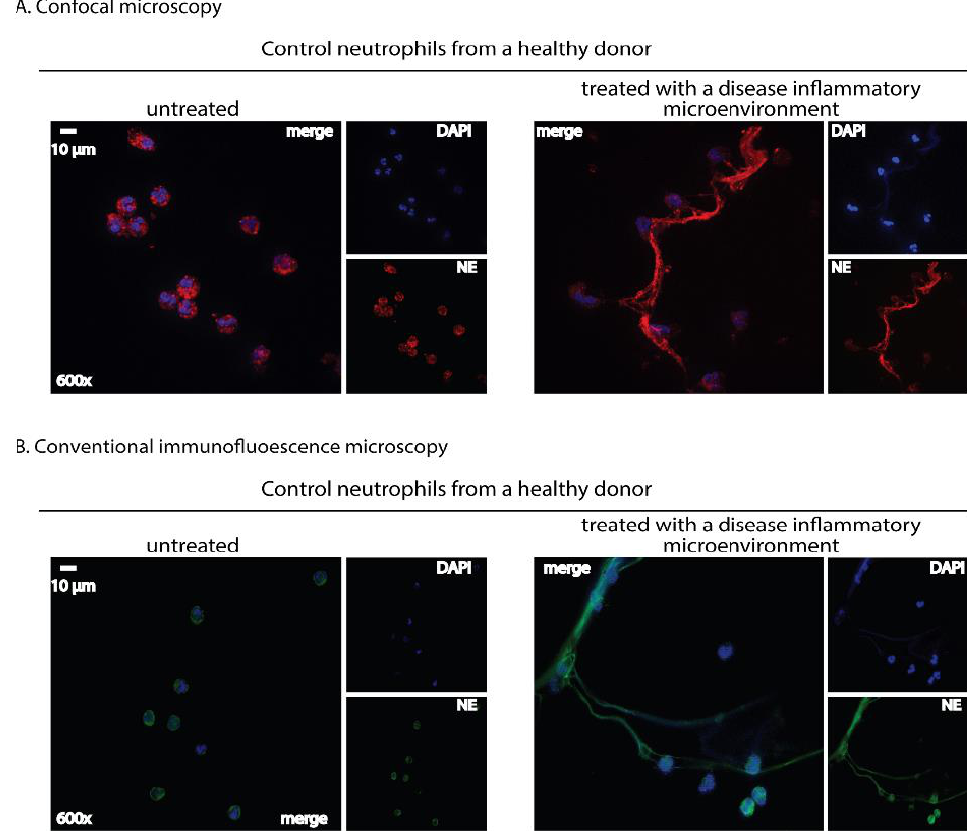
Figure 2. Immunofluorescence staining: A qualitative tool for NET detection in human-isolated neutrophils using either a confocal or a conventional fluorescence microscope. Neutrophils isolated from healthy donors’ whole blood using a density gradient separation method were stimulated with a serum derived from a treatment-naïve patient with active ulcerative colitis (180 min incubation time). NETs are visualized as fibers of extracellular DNA and neutrophil granule proteins assessed by double-staining with a chromatin-staining dye and a neutrophil marker. ( A ) Neutrophils were stained with a rabbit anti-human neutrophil elastase ((NE), Abcam) antibody detected by a goat anti-rabbit AlexaFluor 594 antibody (Invitrogen). Visualization was performed using confocal microscopy (Revolution spinning disk confocal system; Andor, Ireland). ( B ) Neutrophils were stained with a mouse anti-human neutrophil elastase ((NE), Abcam) antibody detected by a goat anti-mouse AlexaFluor 488 antibody (Invitrogen). Visualization was performed using a fluorescence microscope (OLYMPUS BX51). In ( A , B ), cell nuclei were counterstained with 4′,6 -diamidino-2-phenylindole ((DAPI), Sigma-Aldrich). Untreated neutrophils served as control. Data from the Molecular Hematology Laboratory archive are shown.